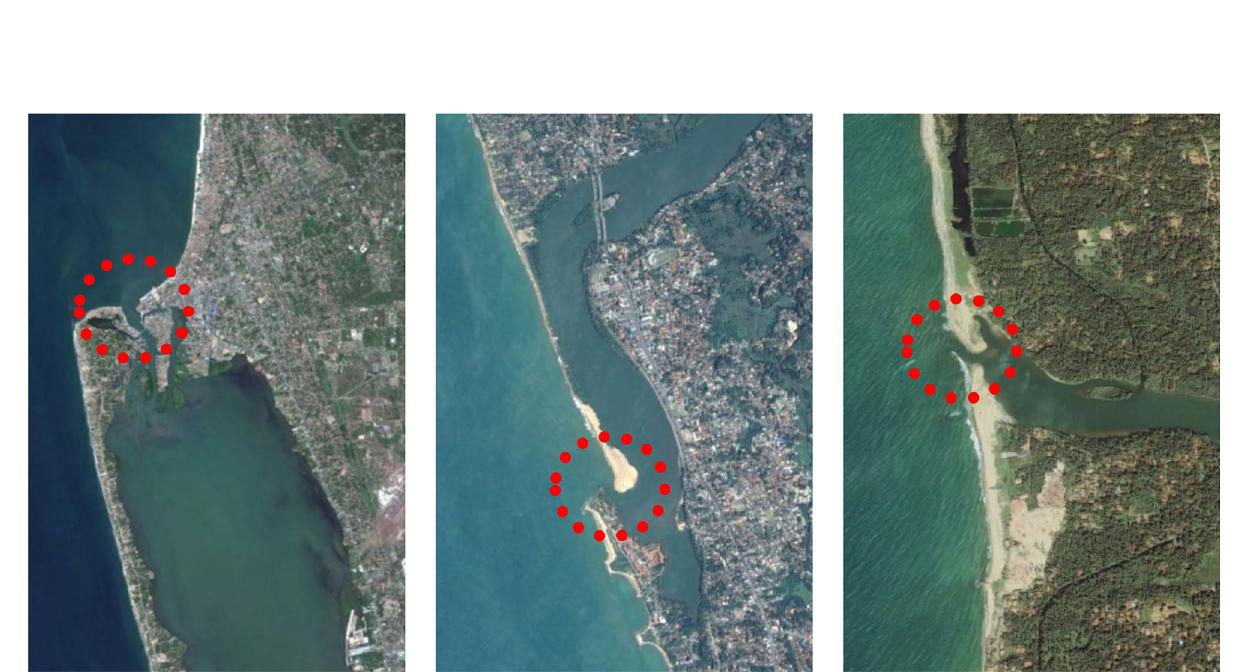
Figure 3. Negombo lagoon – Permanently open, locationally stable inlet: Type 1 (left), Kalutara lagoon – Permanently open, alongshore migrating inlet: Type 2 (middle), Maha Oya river – Seasonally/ Intermittently open, locationally stable inlet: Type 3 (right). The red dotted circles indicate inlet location (Reproduced from Duong et al. 24 , all rights